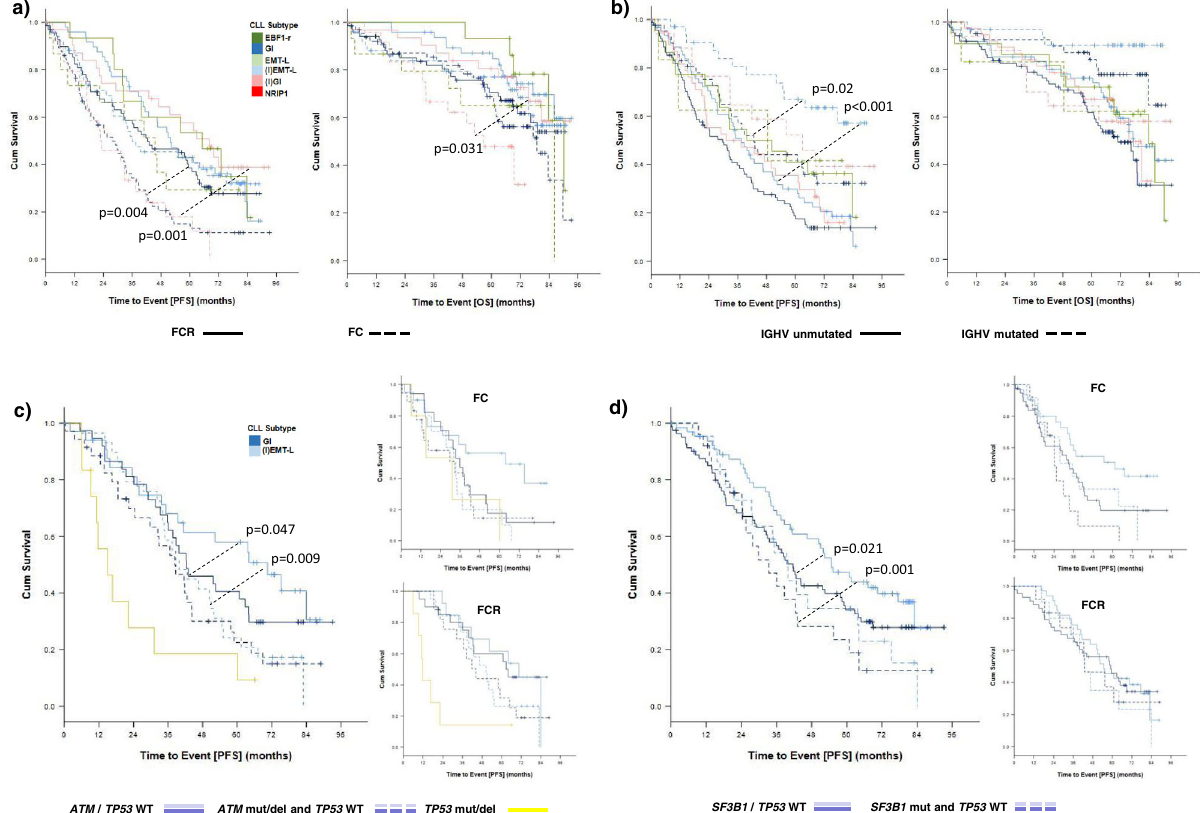
Fig. 5 CLL subtype, genetic markers, and treatment outcome in CLL8. a PFS (left) and OS (right) according to treatment arm (FC: dotted line; FCR: continuous line) and subtype (color-coded) ( n = 319). CLL subtype color code de fi ned in Fig. 5a applies for Fig. 5a, b. b PFS (left) and OS (right) according to the IGHV mutation status and subtype (color-coded) (both treatment arms) ( n = 310). c PFS according to subtypes; GI (dark blue) and (I)EMT-L (light blue), TP53 , and ATM mutation and/or deletion status (shown for all cases and individual treatment arms) ( n = 147). CLL subtype color code de fi ned in Fig. 5c applies for Fig. 5c, d. d PFS in TP53 wild-type cases according to SF3B1 mutation status for GI (dark blue) or (I)EMT-L (light blue) ( n = 193). For Fig. 5a – d, the log-rank test was used to compare the survival distributions. Data within individual fi gures derives from biologically independent